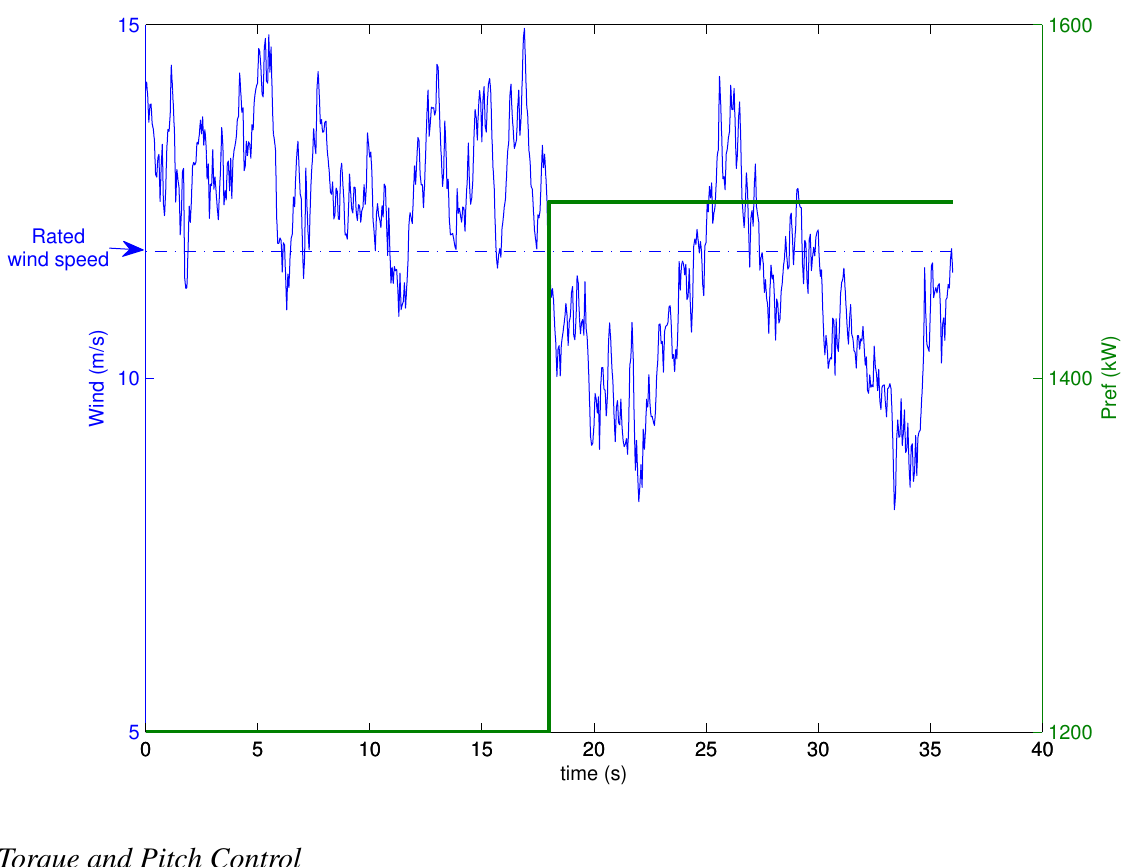
Figure 3. Wind speed profile with a mean of 11 : 8 m/s that corresponds to the rated wind speed of the WT (left y-axes). Reference power (right